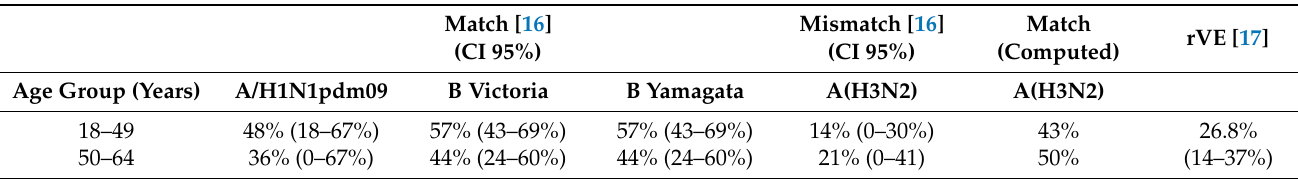
Table 1. Vaccine effectiveness (VE) for QIVe and QIVc, per age-group, based on estimates of relative vaccine effectiveness (rVE) between the two vaccines [16,17].